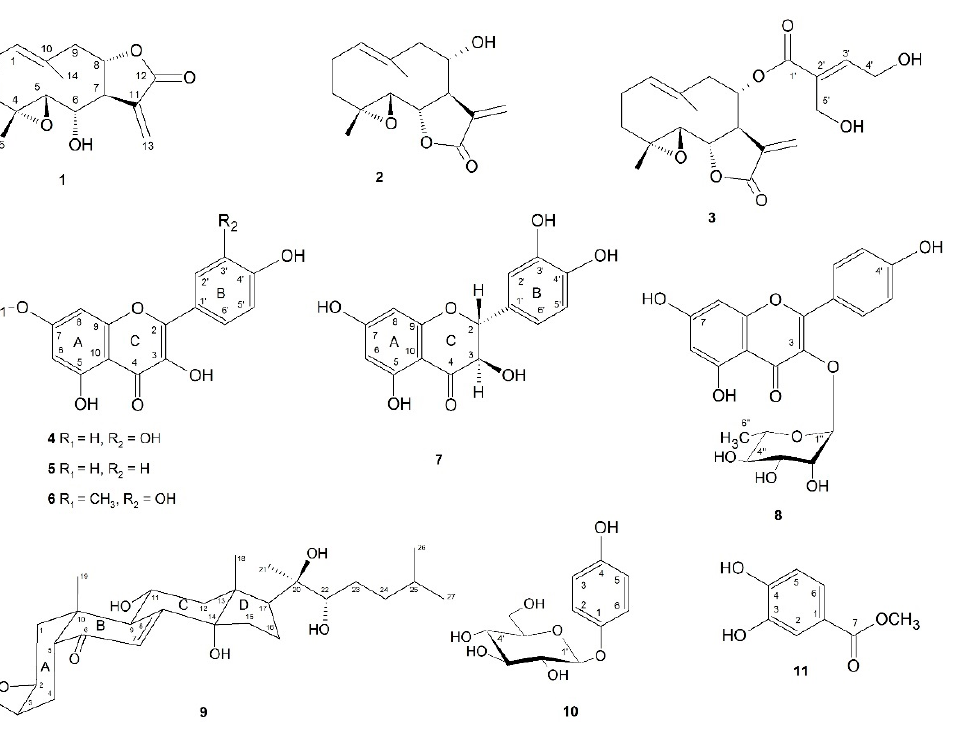
Figure 1. Chemical structures of compounds 1 – 11 ( 1 —izospiciformin, 2 —stizolin, 3 —stizolicin, 4 —quercetin, 5